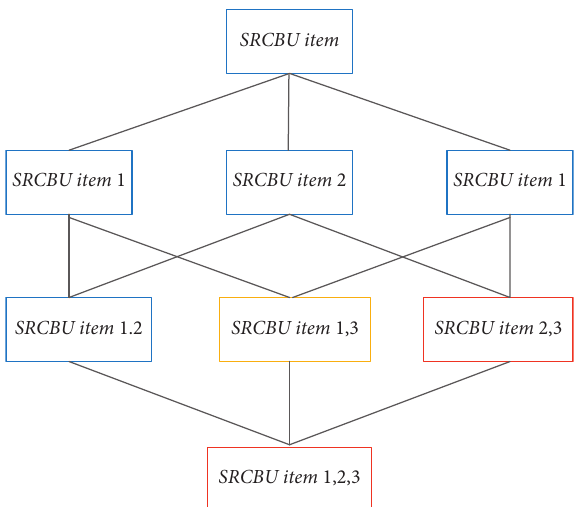
Figure 6: The property of frequent item-sets of SRCBU